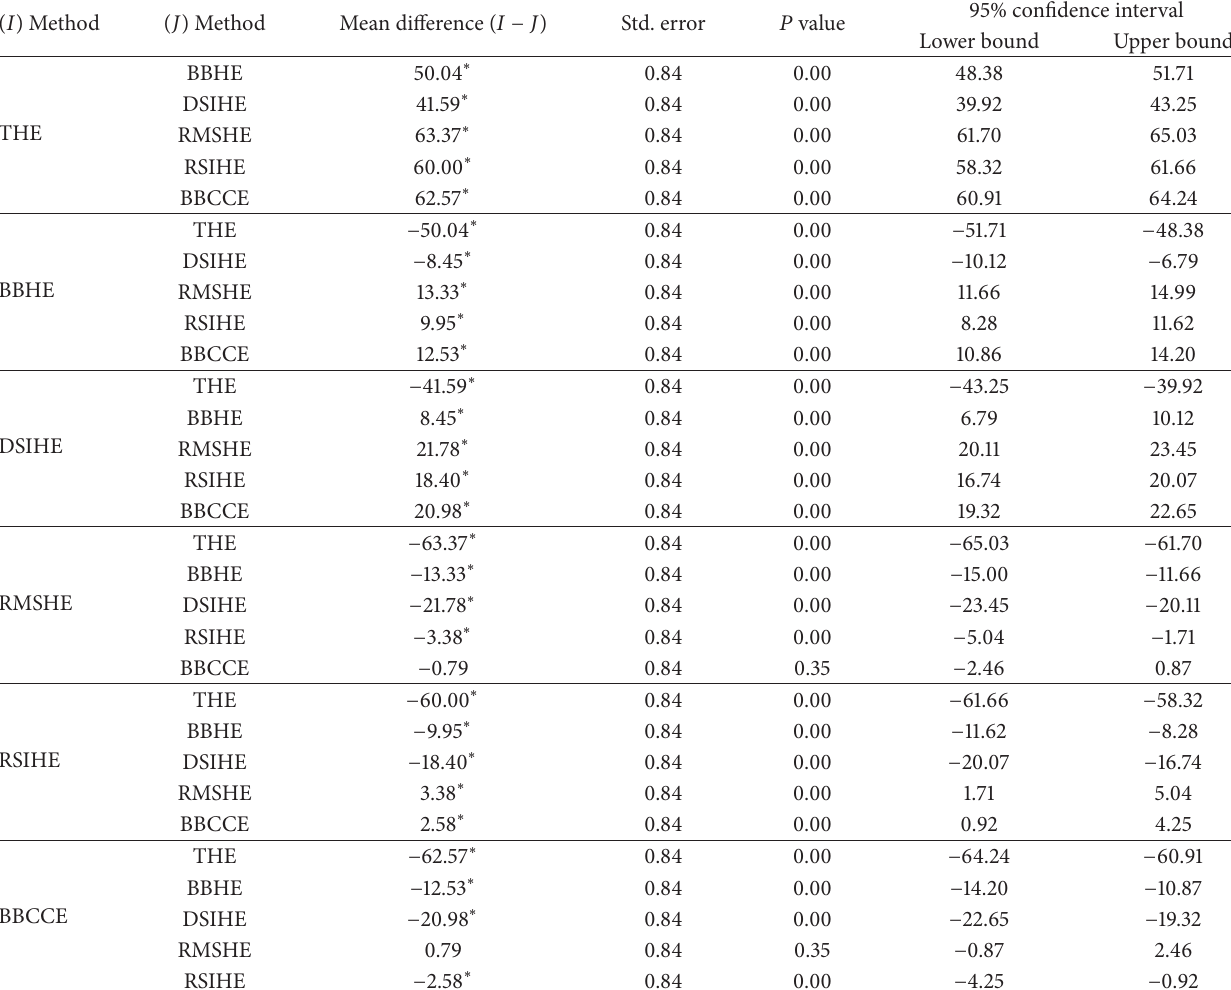
Table 5: Categorization of different methods using Fisher’s Least Significance Difference (LSD) for AMBE. ( 𝐼 ) Method